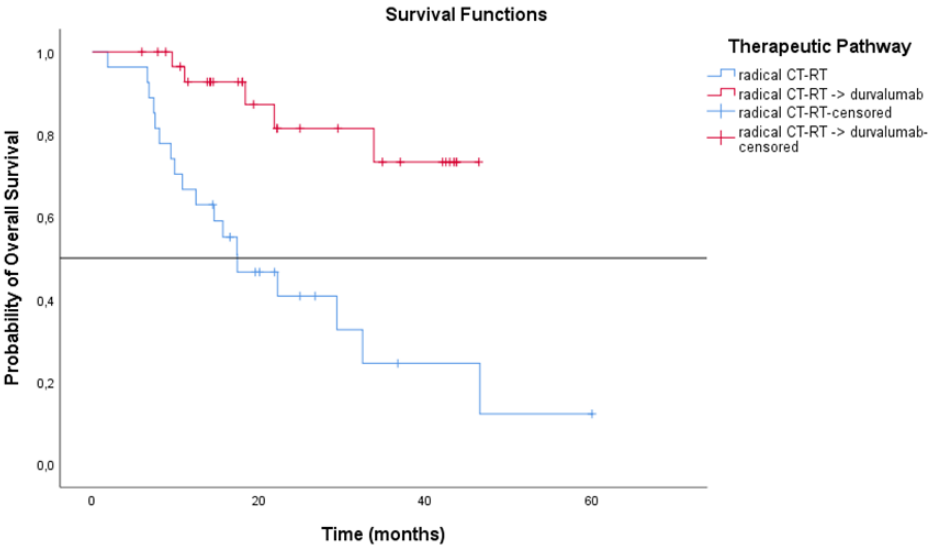
Figure 19. Kaplan–Meier curves of estimated overall survival in patients treated after 2018 who underwent definitive chemo-radiation therapy according to treatment pathway. CT-RT, chemo-radiation therapy.